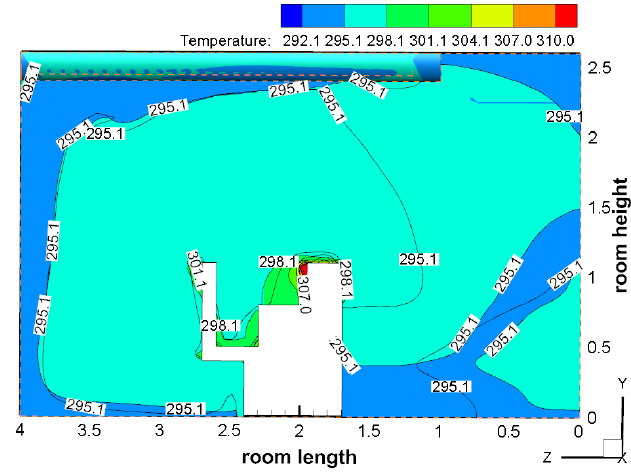
Figure 26. The temperature distribution of the Y = 0.6 m section.